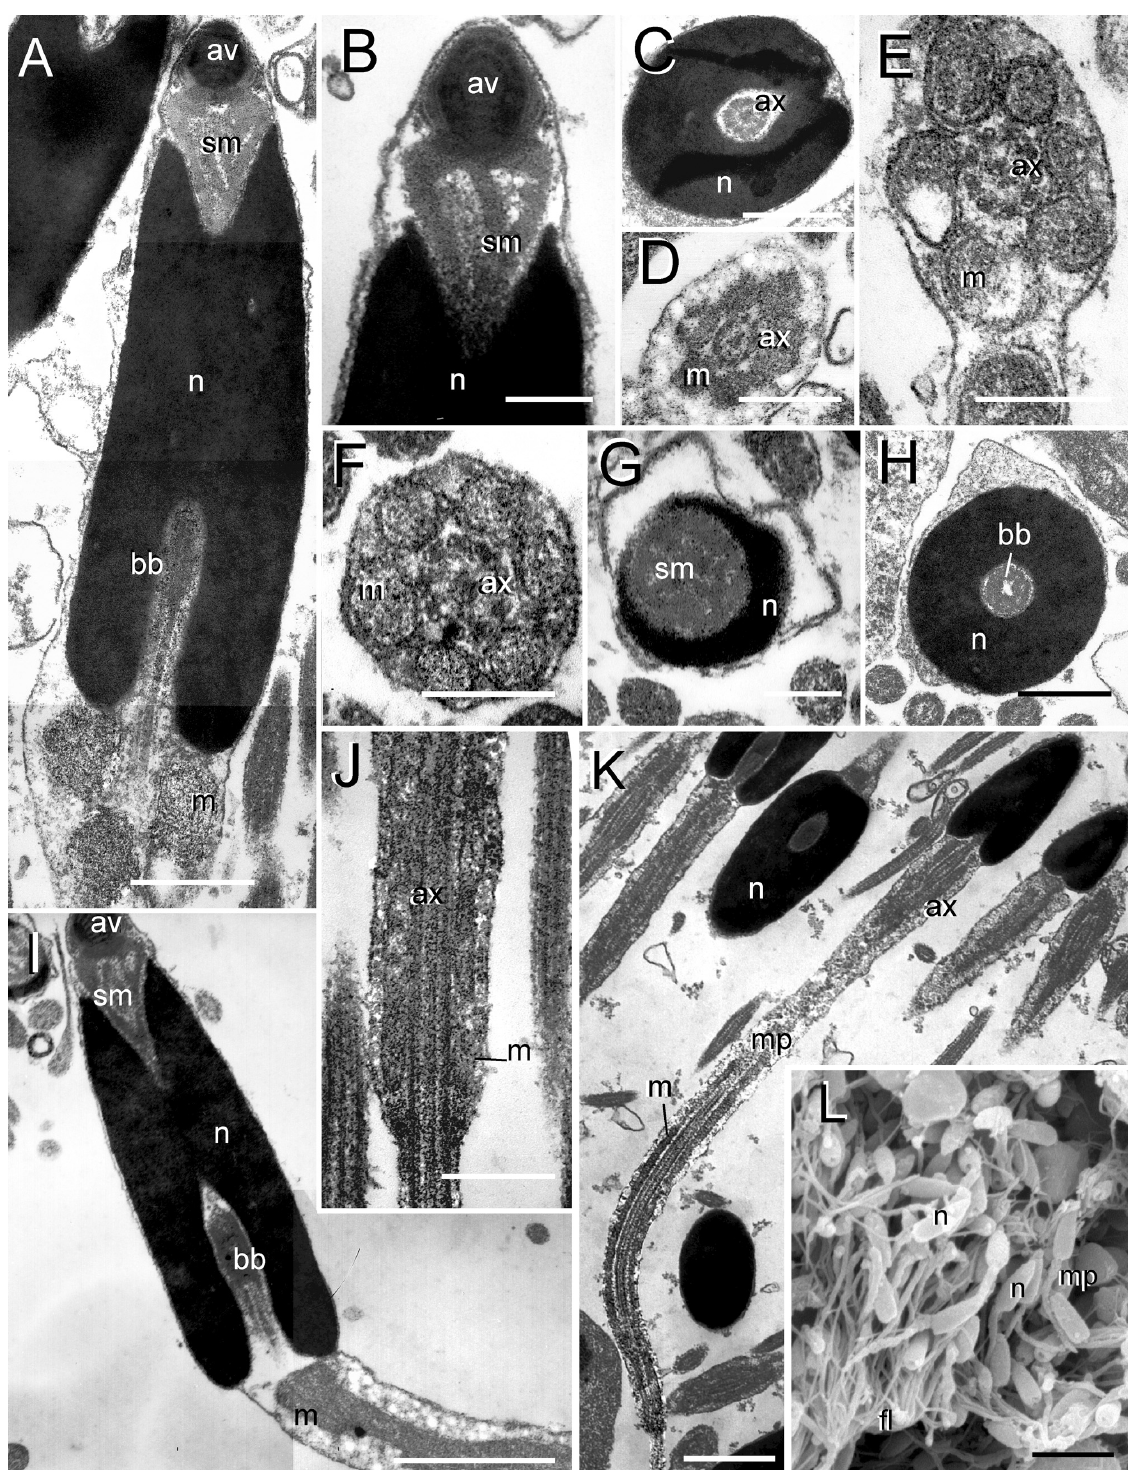
FIG. 3. – Asetocalamyzas laonicola , mature spermatozoon: A, longitudinal section through nucleus (TEM); B, acrosome of late spermatid, subacrosomal space well developed (TEM); C, transverse section through the posterior depression of mature spermatozoon (TEM); D, trans- verse section through transitional zone between midpiece and flagellum of mature spermatozoon, six mitochondria are seen (TEM); E, trans- verse section through midpiece, six mitochondria around the flagellum (TEM); F, transverse section through the midpiece, axonema has typ- ical structure (9x2 + 2) (TEM); G, transverse section through nucleus, frontal depression (TEM); H - transverse section through nucleus, pos- terior depression (TEM); I, longidudinal section through nucleus and midpiece. Mitochondria have bright white vesicles along their whole length (TEM); J, transitional zone between midpiece and flagellum (TEM); K, midpiece, longitudinal section (TEM); L, spermatozoa in the body cavity (TEM). Scale: A, B, C, E, G, H, J, 0.5 μ m; D, I, K, 1.0 μ m; F, 0.3 mm; L, 3.0 μ